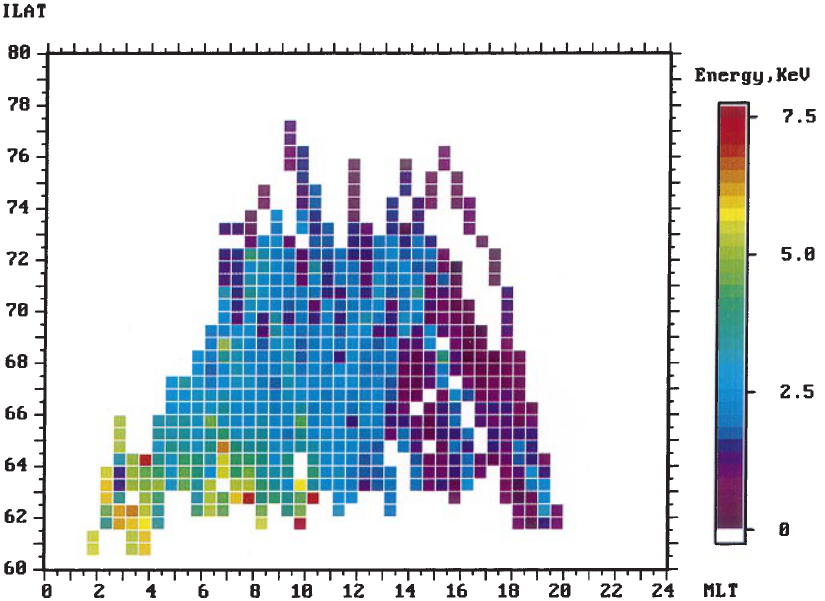
Fig. 3. Statistical distribution of the average H + energy (coded according to the color scale at right ) within gaps as a function of MLT and ILAT. This statistics is based upon 168 passes of INTERBALL-Auroral over the auroral zone, from October 1, 1996 to June